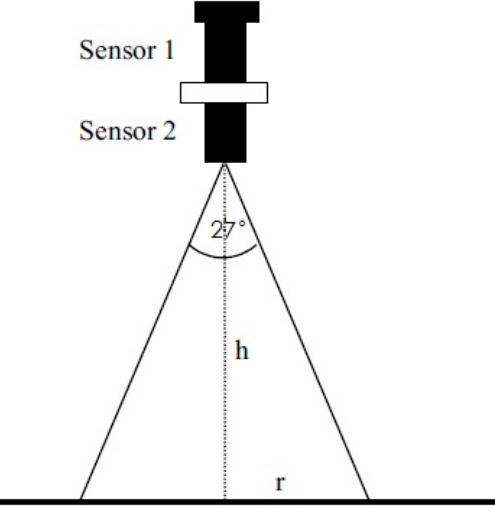
Figure 3. Measurement principles of the multispectral crop-growth sensor. Note: Sensor 1 and sensor 2 represent the solar sensor and two-band sensor, respectively.